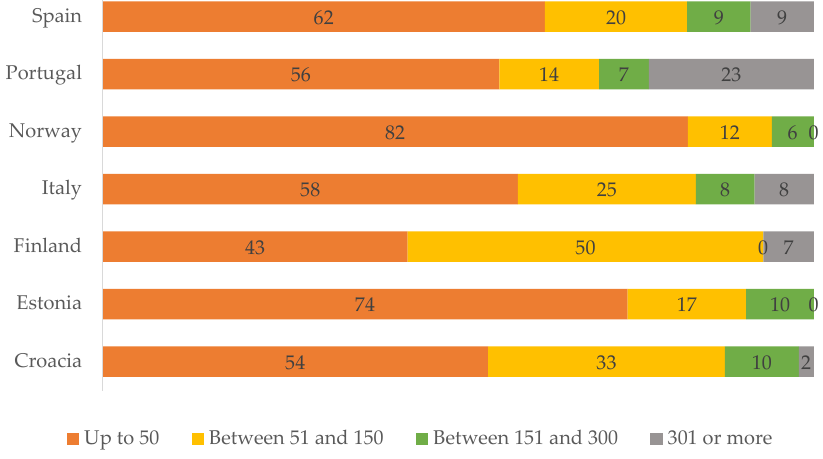
Figure 4. Relative distribution of number of honeybee colonies by country (%).